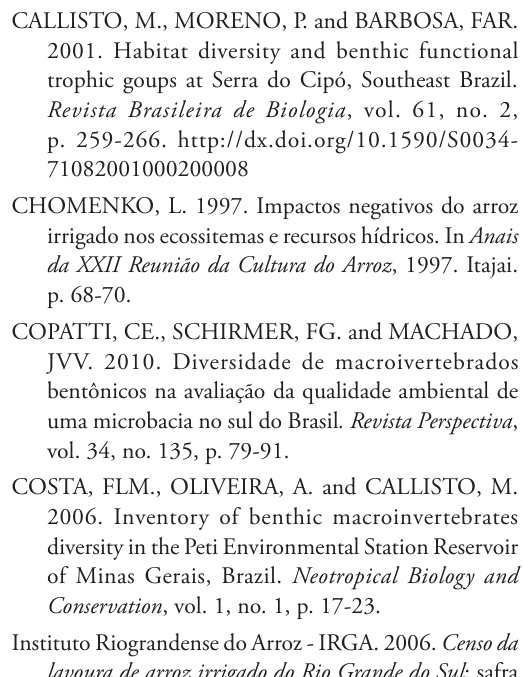
Figure 2. Abundance of trophic functional groups found- ed at rice cultivarion (R) and wetlands (W) at different sample periods (1 and 2 – January, 3 and 4 – February, 5 and 6 –